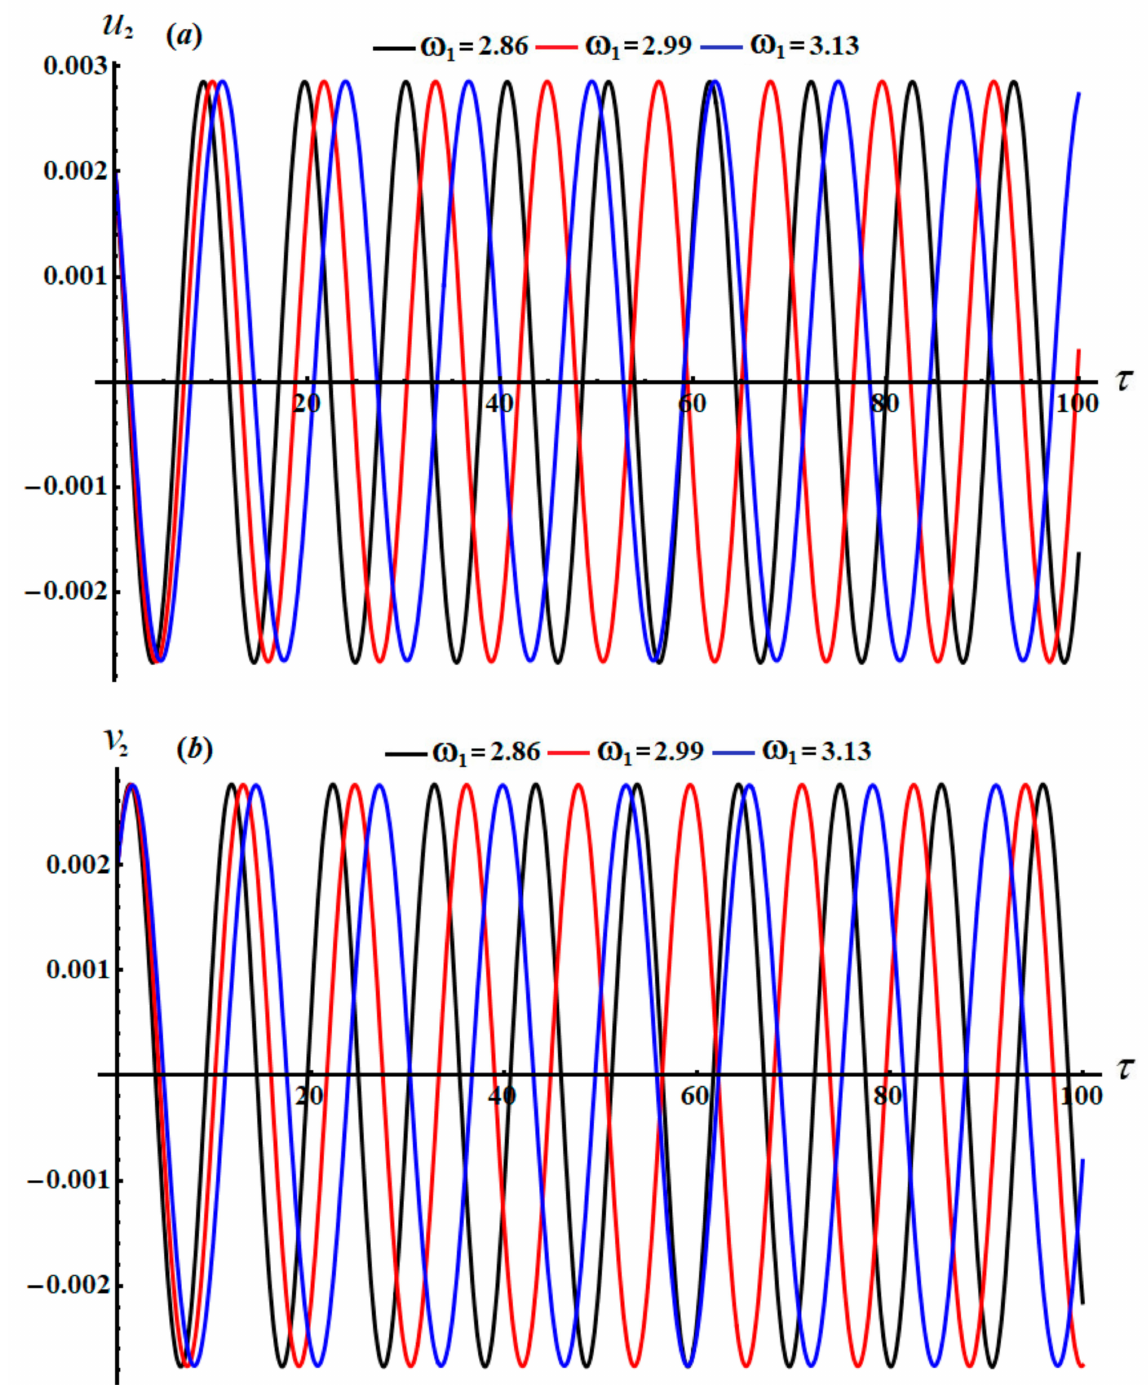
Figure 13. Sketches of the modified amplitudes versus τ when ω 1 = ( 2.86,2.99,3.13 ) : ( a ) u 2 , ( b ) v 2